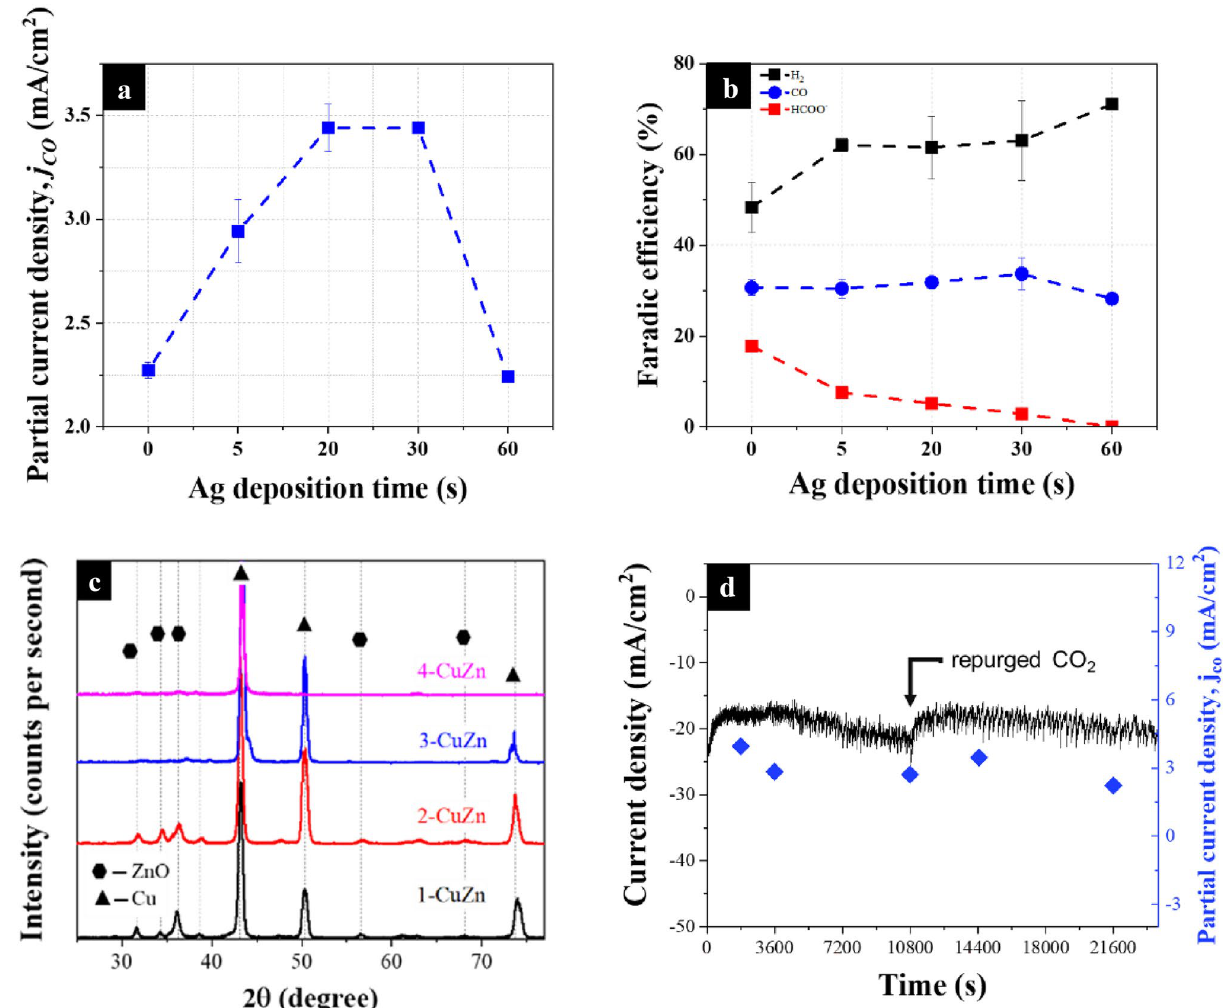
Figure 4. ( a ) The partial current densities of CO across different Ag deposition times at − 0.91 V vs. RHE for sample 3-CuZn ( b ) Faradic efficiency and the ratio of product gases of 3-CuZn with different Ag depositions times at − 0.91 V vs. RHE ( c ) Grazing angle XRD patterns for all samples after electrochemical CO 2 RR at − 0.91 V vs. RHE ( d ) stability showing the current density and partial current density for 3-CuZn with 20 s Ag deposition at − 0.91 V vs.